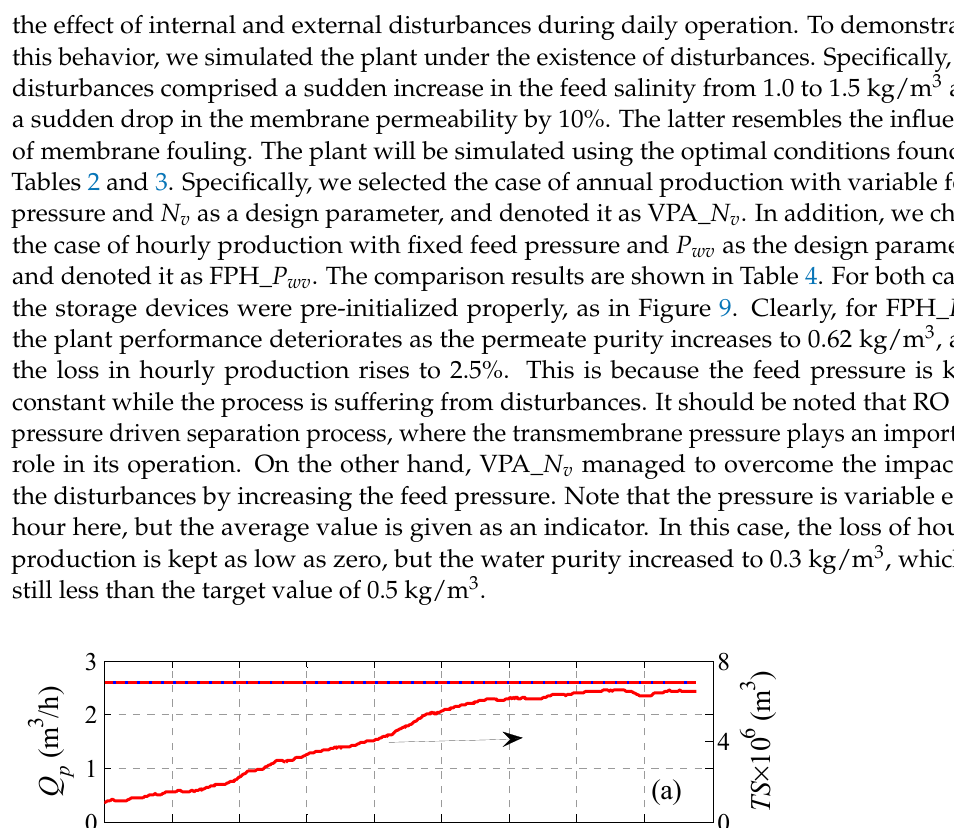
Table 4. Comparing operation under disturbances.